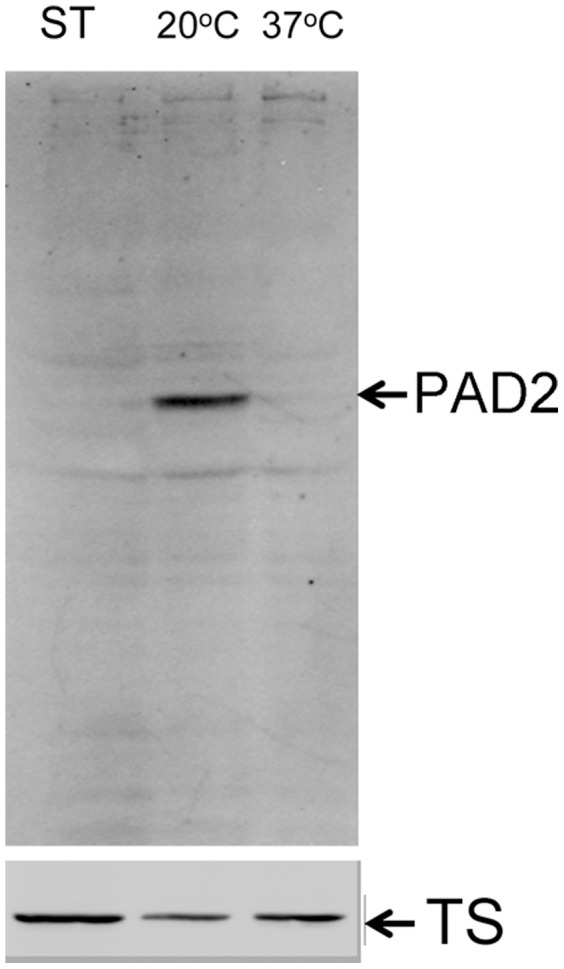
PAD2 is expressed predominantly only upon cold shock of stumpy forms.Western blot for the expression of PAD 2 in stumpy forms freshly harvested from a rodent infection (ST) or incubated in HMI9 medium at either 20°C or 37°C. PAD2 expression is clear at 20°C but little is expressed at 37°C. This matches the analysis previously reported by Dean et al 2009 [10]. Analysis of the same samples using an antibody to trypanothione synthetase (TS) provided a loading control.